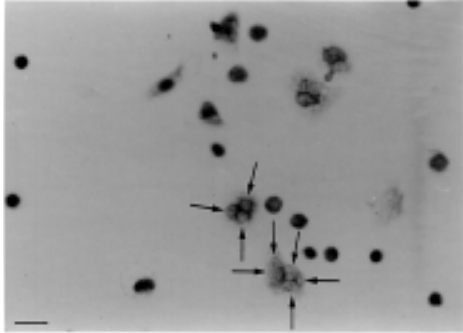
Figure 1 - Phagocytosis assay. Phagocytic macrophages were identified as cells that internal- ized three or more zymosan par- ticles. The identification of phag- ocytosis in a typical experiment is indicated by arrows. Macro- phages were stained with Leishman solution (13). Magnifi- cation, 400X; bar represents 10